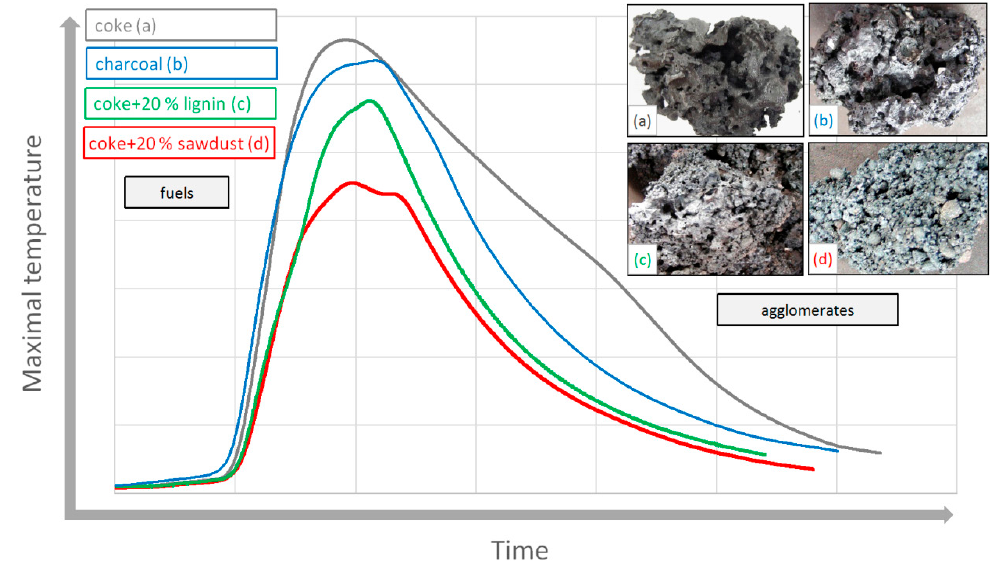
Figure 9. Diagram of maximal temperatures in sintering experiments with various fuels. ( a ) Agglomerate produced with coke; ( b ) agglomerate produced with charcoal; ( c ) agglomerate produced with coke + 20% lignin; and ( d ) agglomerate produced with coke + 20% sawdust.